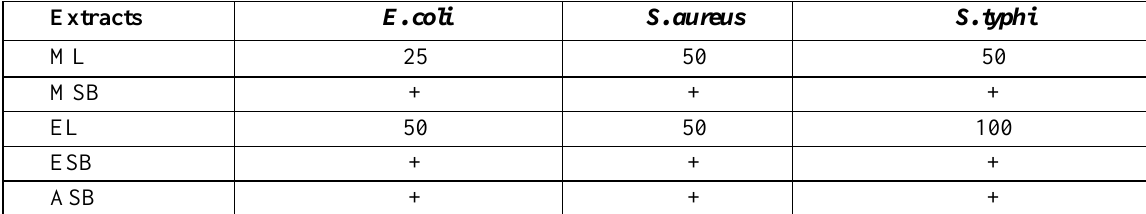
Table 5. Minimum bactericidal concentration (mbc) of the extracts against the test organisms mg/ml.